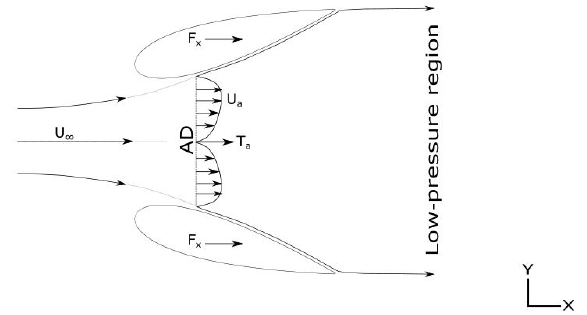
Figure 1. Schematic of a diffuser-augmented wind turbine.